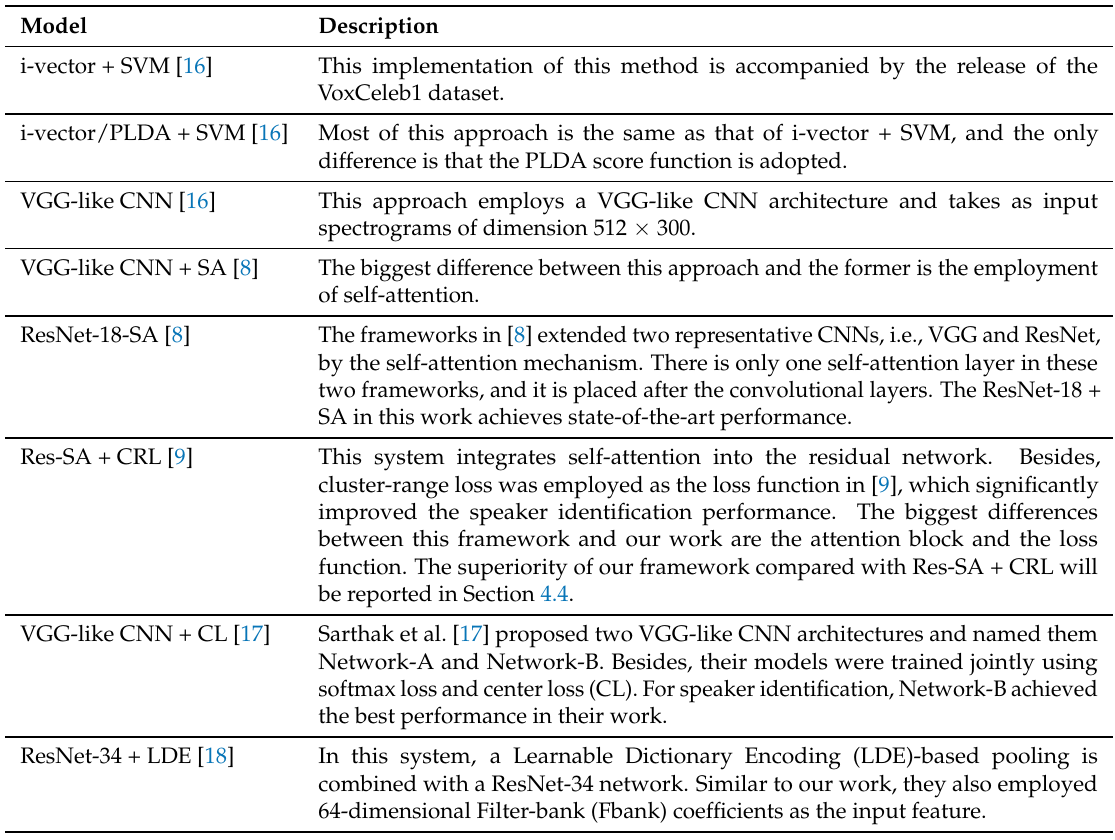
Table 6. Different baselines for speaker identification.